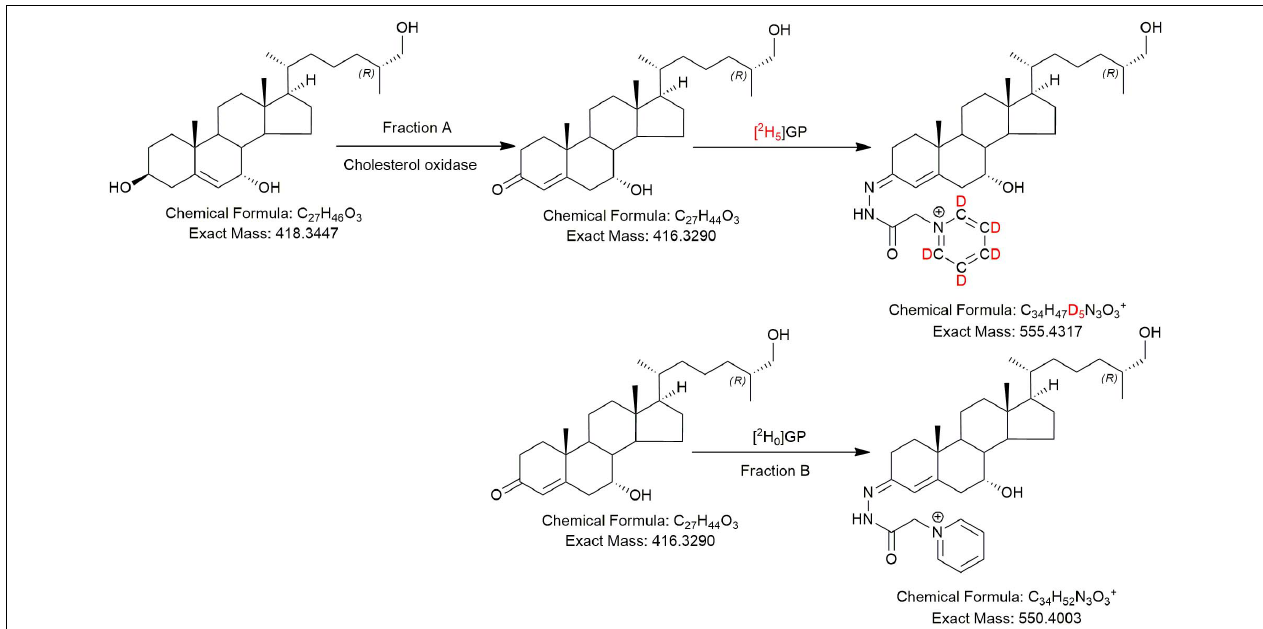
FIGURE 2 | The EADSA derivatisation method. Samples are split into two equal fractions A and B. A-fractions are treated with cholesterol oxidase enzyme and [ 2 H 5 ]GP, B-fractions are treated with [ 2 H 0 ]GP in the absence of cholesterol oxidase. LC-MS(MS 3 ) analysis of fraction-A reveals compounds with a 3 β -hydroxy-5-ene structure plus those with a native 3-oxo-4-ene structure, while analysis of fraction-B reveals native 3-oxo-4-ene compounds only. Deconvolution of data from A and B allows quantification of 3 β -hydroxy-5-ene compounds while data in B allows quantification of native 3-oxo-4-ene compounds (and 7-oxo-5-ene).